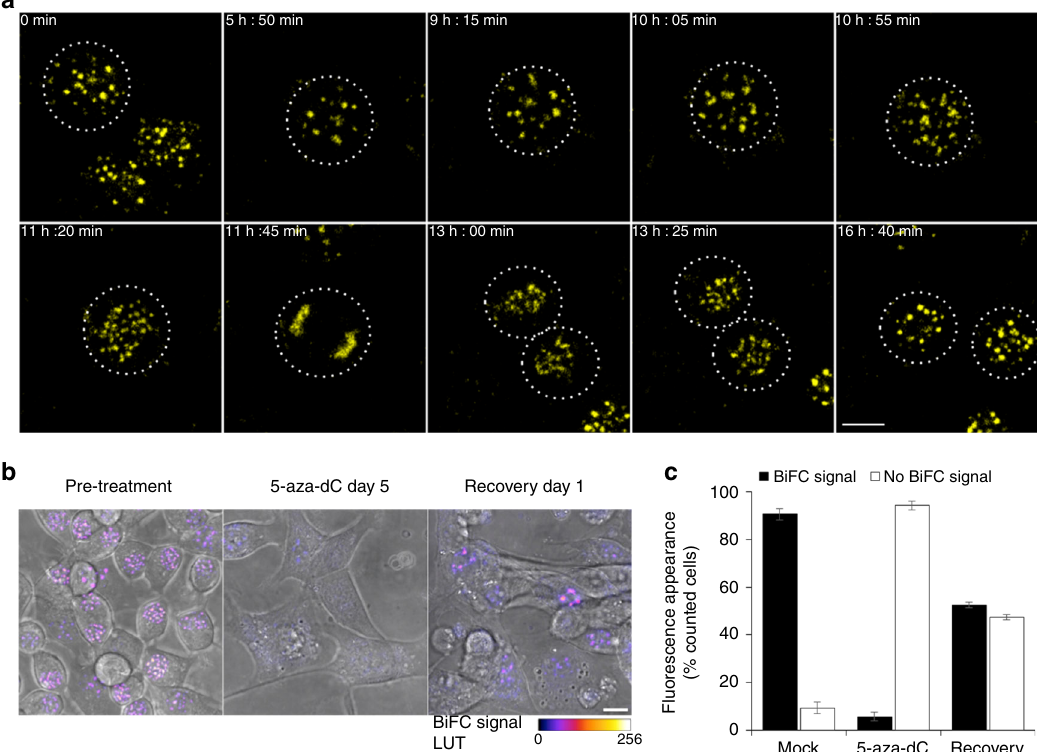
Fig. 7 Real-time visualization of DNA methylation levels on major satellite repeats with BiAD sensor 1. a Live-cell imaging of cells stably expressing the BiAD sensor 1 modules. The time points at which images were taken are annotated. The panels are centered on the cell that undergoes mitosis during the imaging interval. To facilitate visualization, this cell was marked with a dotted circle . The imaging and data display conditions are identical between the shown time points. b Representative phase contrast- fl uorescence channel overlay images during the 5-aza-dC DNA demethylation treatment of the cell line stably expressing BiAD sensor 1. To facilitate visualization, the BiFC signal was pseudo colored. The imaging and data display conditions are identical between the three panels of the composite image. c Quanti fi cation of the experiments representatively shown in panel. Error bars represent s.e.m. for two biological replicates (for details cf . Supplementary Tables 6 and 7). Scale bar for all images is 10 µ